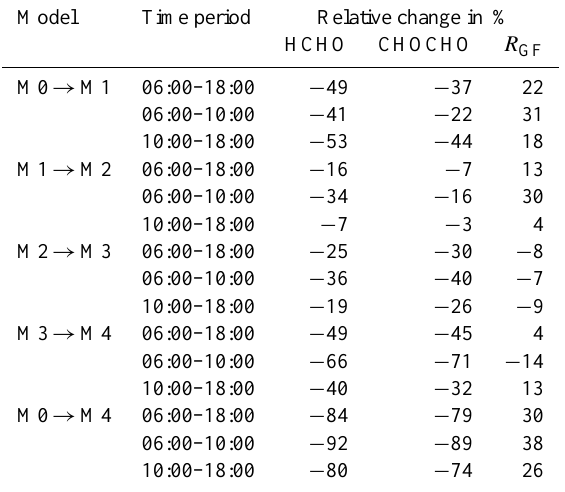
Table 3. Relative changes of HCHO and CHOCHO mixing ra- tio and R GF under different model simulations (Table 1) for the PRIDE-PRD2006 campaign. When the model scenario is changing from M i to M j ( i,j ∈ [ 0 , 4 ] ), the relative change in percentage is calculated as % = 100 × (M j − M i )/M i